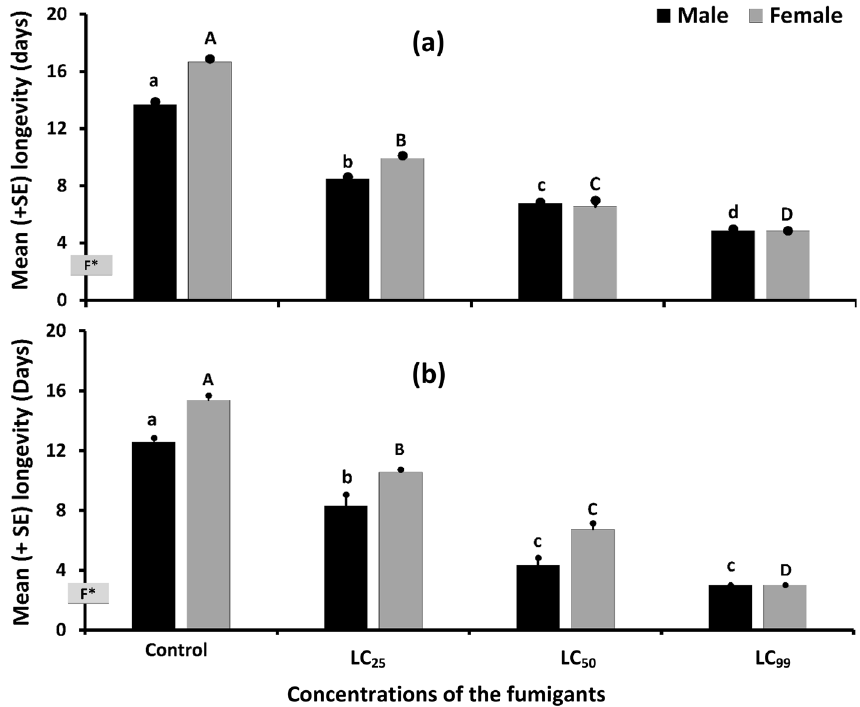
Figure 2. Female and male C. chinensis longevity after fumigation with LC 25 , LC 50 and LC 99 doses of ( a ) phosphine and ( b ) ethyl formate (n = 3, each with 60 individuals). F* on the vertical (Y-) axis denotes for duration (24 h) of fumigation